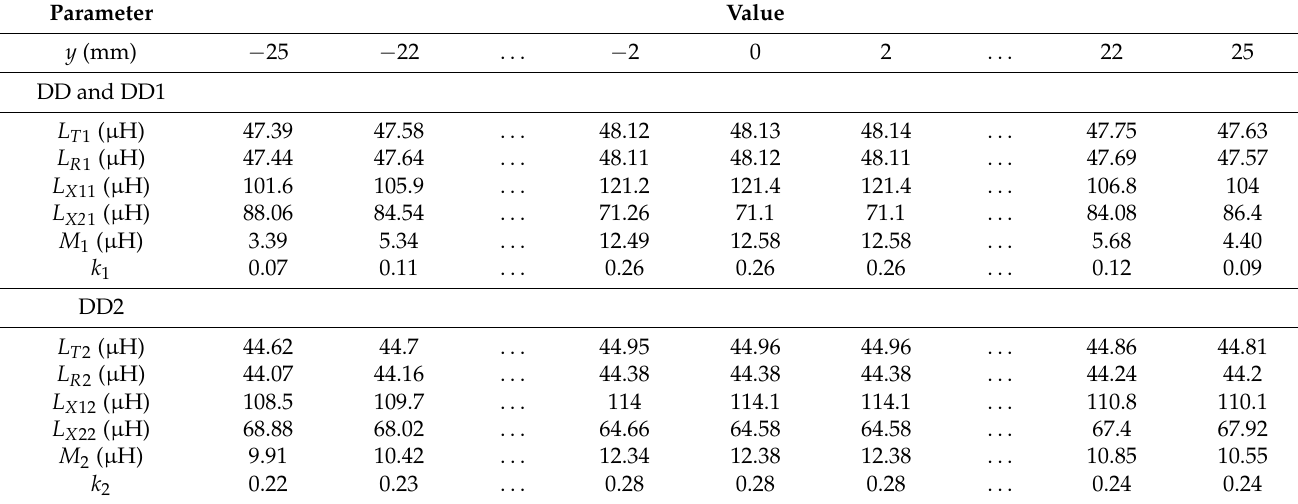
Table 4. Coupling coefficient measurements of the (DD) DD1 and DD2 coils in the y -axis at x = 0 and z = 25.3 mm.